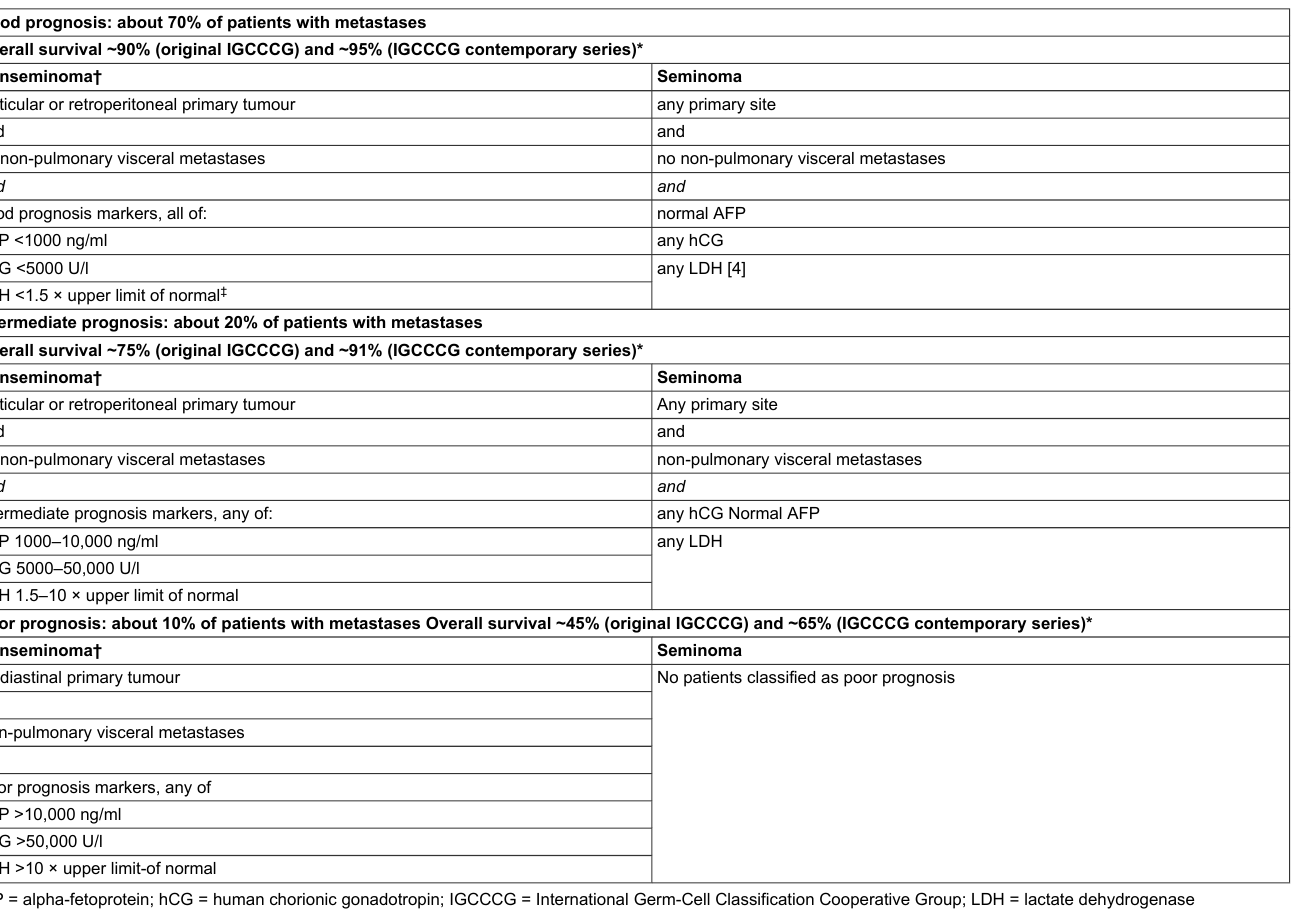
Table 1: Prognostic categories according to the original IGCCCG classification [5] Good prognosis: about 70% of patients with metastases